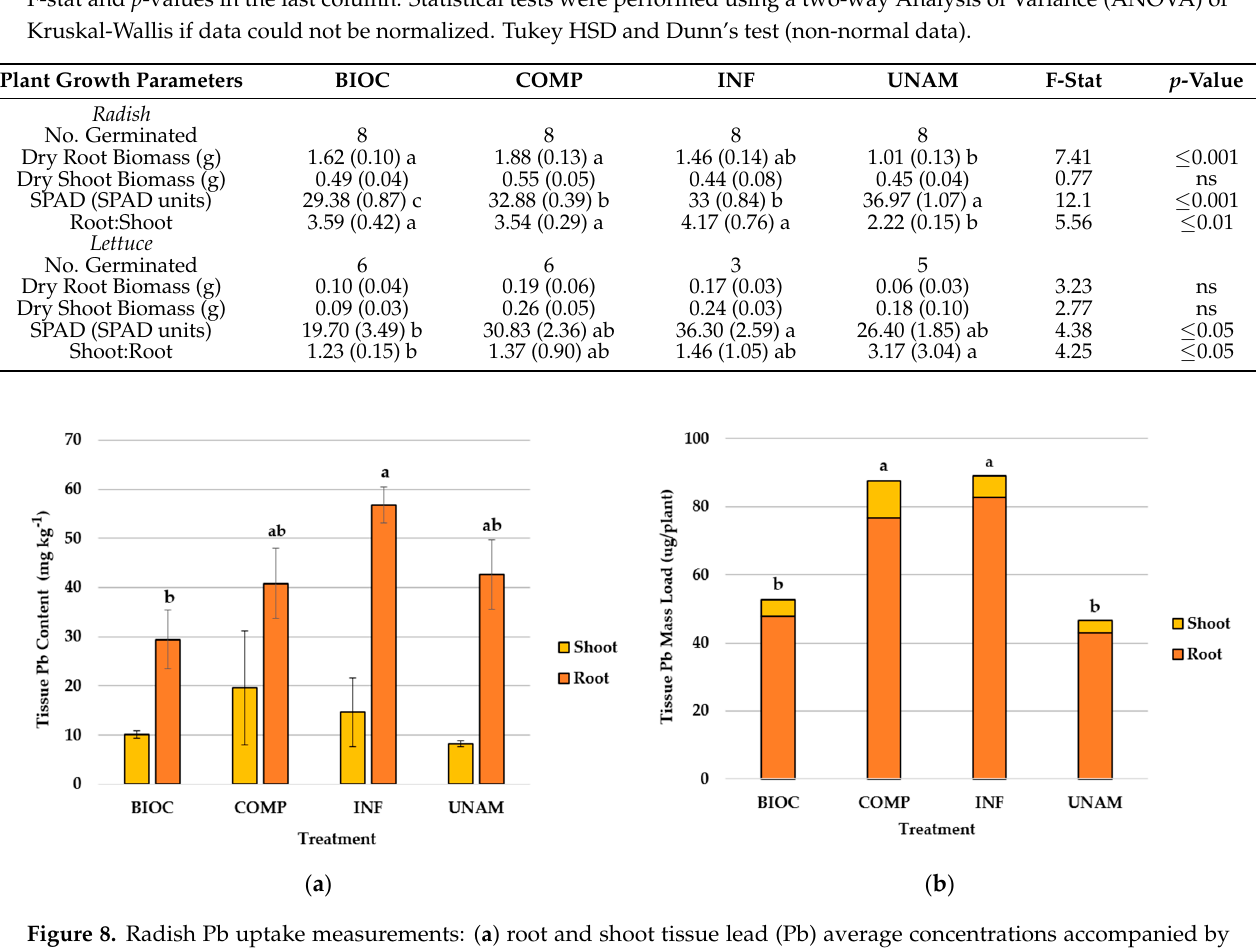
Figure 8. Radish Pb uptake measurements: ( a ) root and shoot tissue lead (Pb) average concentrations accompanied by mean error bars; ( b ) average root and shoot mass loads for plants grown in soils amended with biochar (BIOC), compost (COMP), inorganic fertilizer (INF), and unamended control (UNAM). Lowercase letters on each figure indicate statistically significant differences between treatments. Statistical tests were performed using a two-way Analysis of Variance (ANOVA) or Kruskal-Wallis if data could not be normalized. Tukey HSD or Dunn’s test (non-normal data) were used to determine treatment significance at a minimum of p ≤ 0.05.